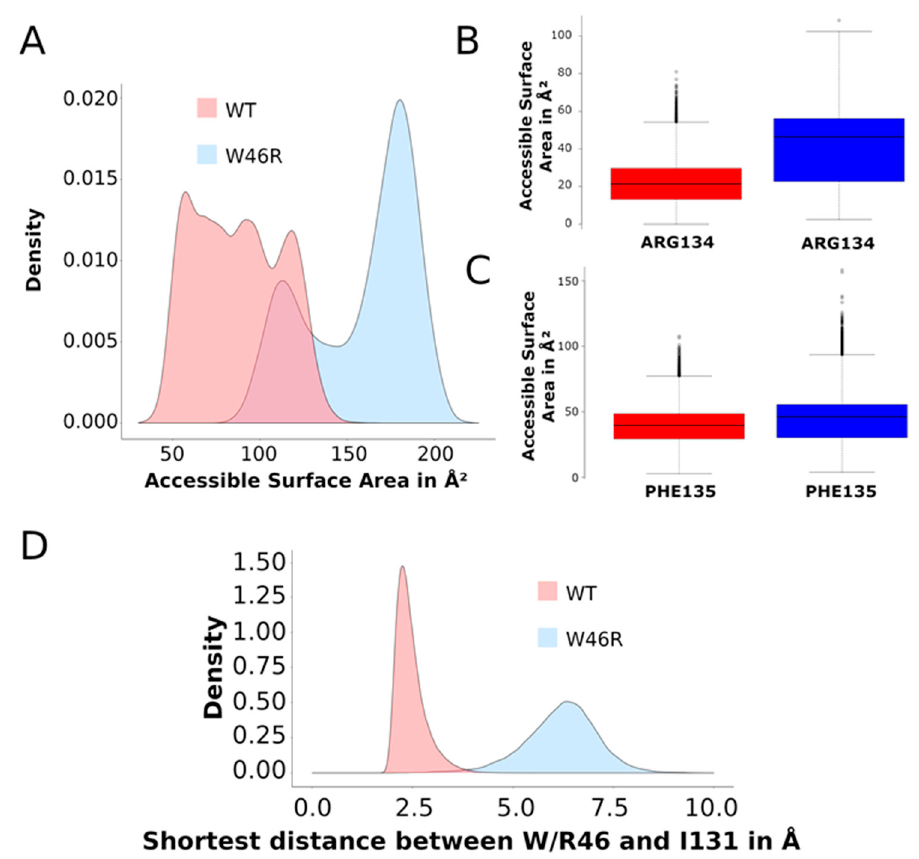
Figure 4. Accessible surface areas and shortest distances on MDeNM structures. ( A ) Histogram of accessible surface area (ASA) values of residue W46 in KirBac3.1 WT (in red) and R46 in KirBac3.1 W46R (in blue) obtained on the set of relaxed MDeNM structures. ( B ) Boxplot of ASA values of R134 in KirBac3.1 WT (in red) and in KirBac3.1 W46R (in blue) over the same set of structures. ( C ) Boxplot of ASA values of F135 in KirBac3.1 WT (in red) and in KirBac3.1 W46R (in blue) over the same set of structures. ( D ) Histogram of the shortest distances on MDeNM structures between residue 46 and I131 in KirBac3.1 WT (in red) and KirBac3.1 W46R (in blue).